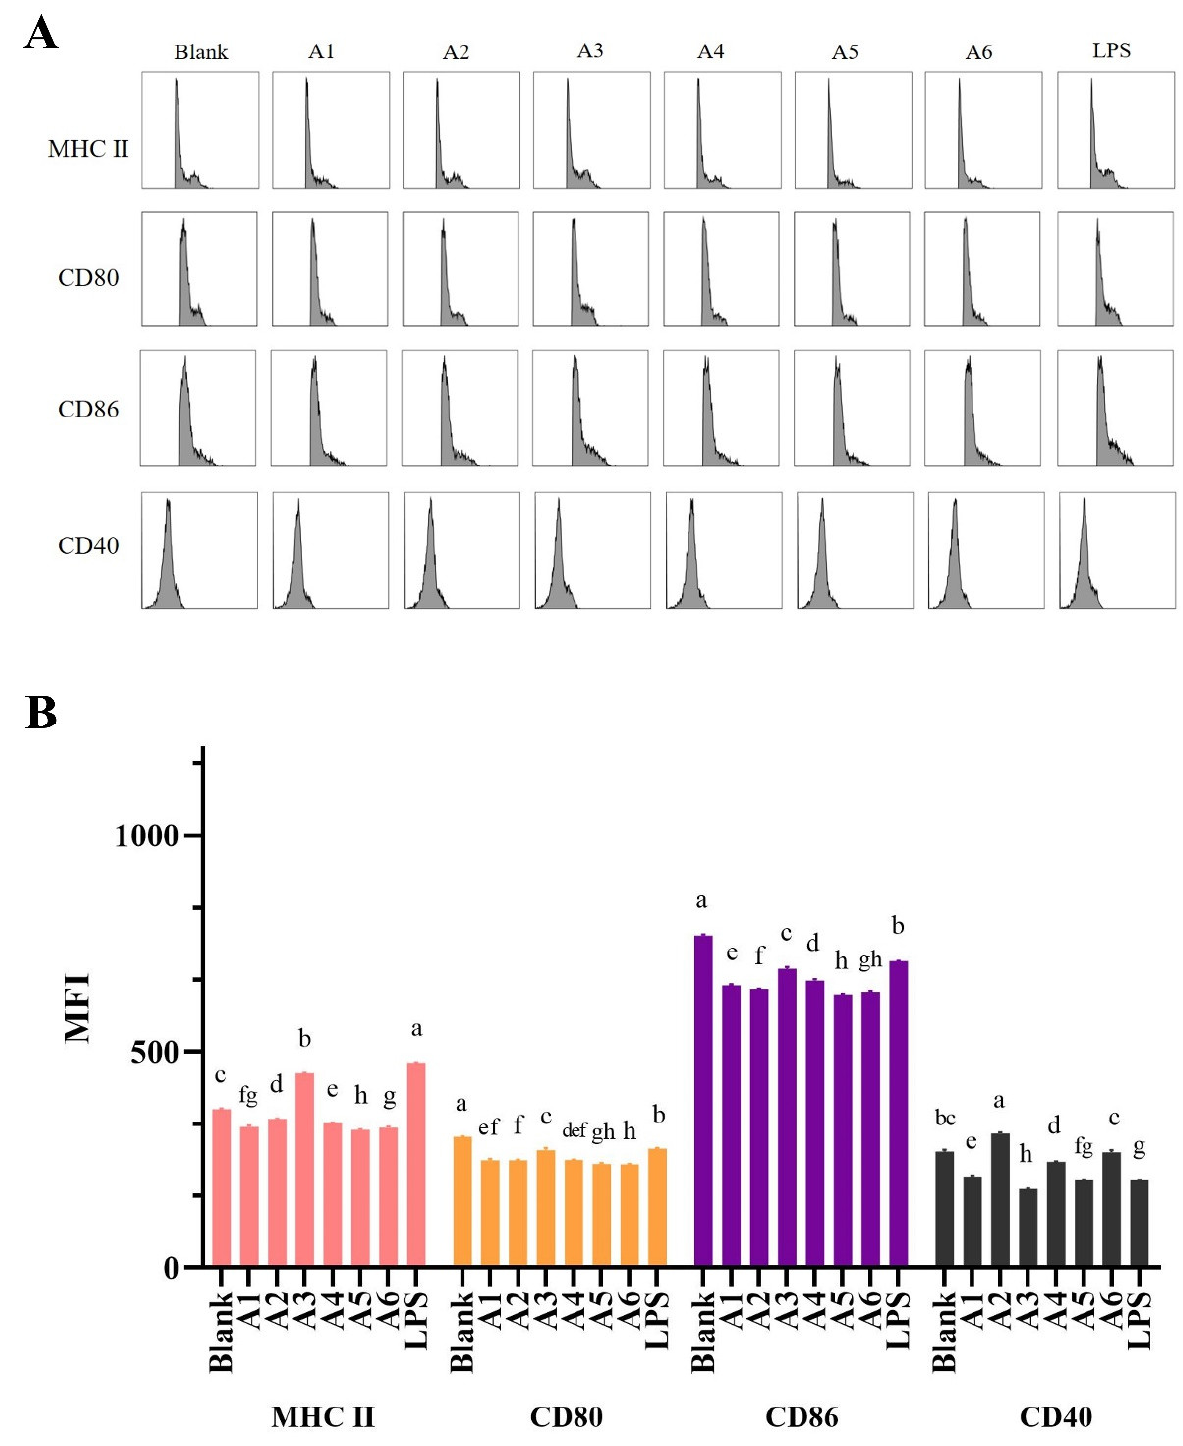
Figure 3. BLG 40–60 promoted the maturation of LP cells in the peptide–LP cell assay. ( A ) The histogram results of MHC II, CD80, CD86, and CD40 of LP cells with different stimulation of peptides or LPS. ( B ) Bar graphs showing the MFI levels of MHC II, CD80, CD86, and CD40 summarized from ( A ), respectively. The results are represented as the mean ± SD ( n = 3, the data were calculated in three replicates, the same letters indicate the lack of significance of the MHC II/CD80/CD86/CD40 column, as determined by two-way analysis of variance (ANOVA) with Duncan’s post-test ( p < 0.05)). LP cells, intestinal lamina propria cells. MHC II, MHC classic molecule II. MFI, median fluorescence intensity.